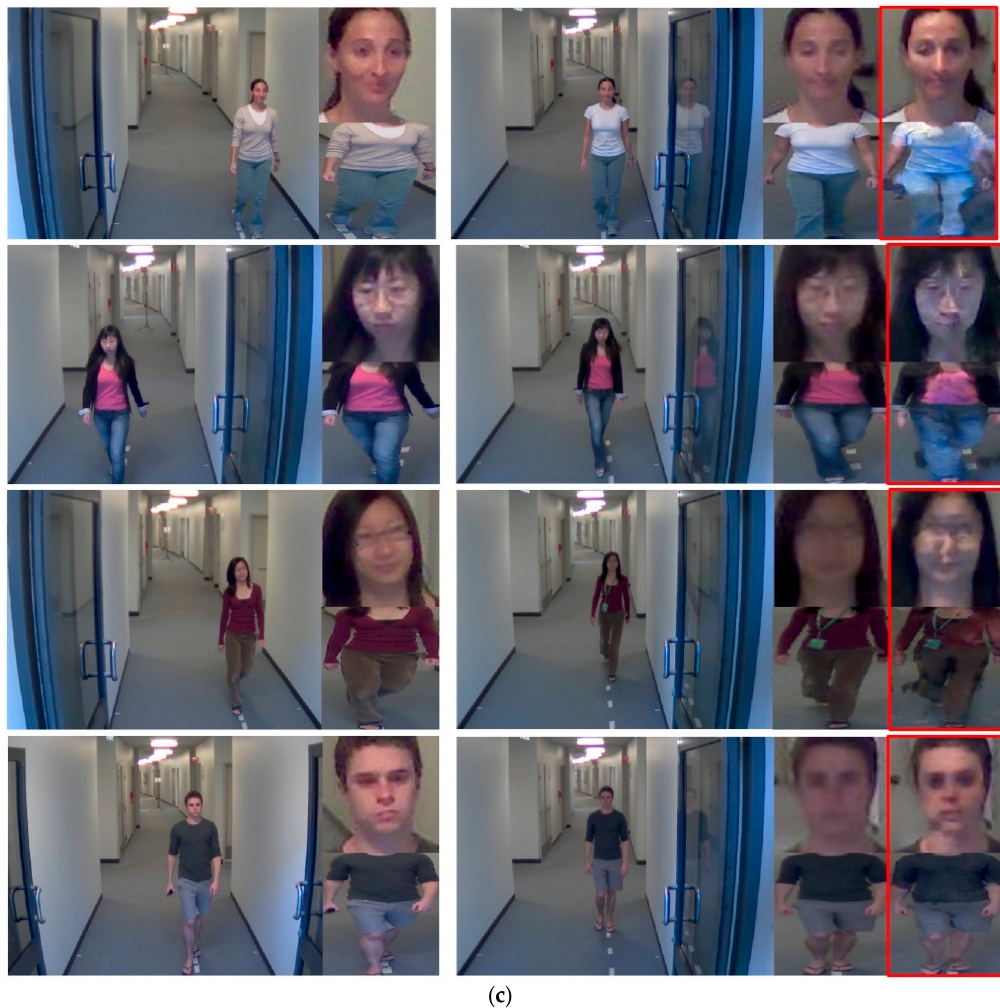
Figure 18. Cases corresponding to false acceptance (FA), false rejection (FR), and correction recognition ( a )–( c ) Cases from ChokePoint dataset ( a ) FA cases, ( b ) FR cases, and ( c ) cases of correct